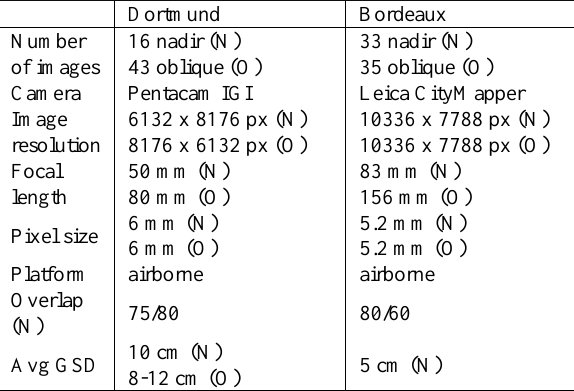
Table 1 . Properties of the datasets used in the